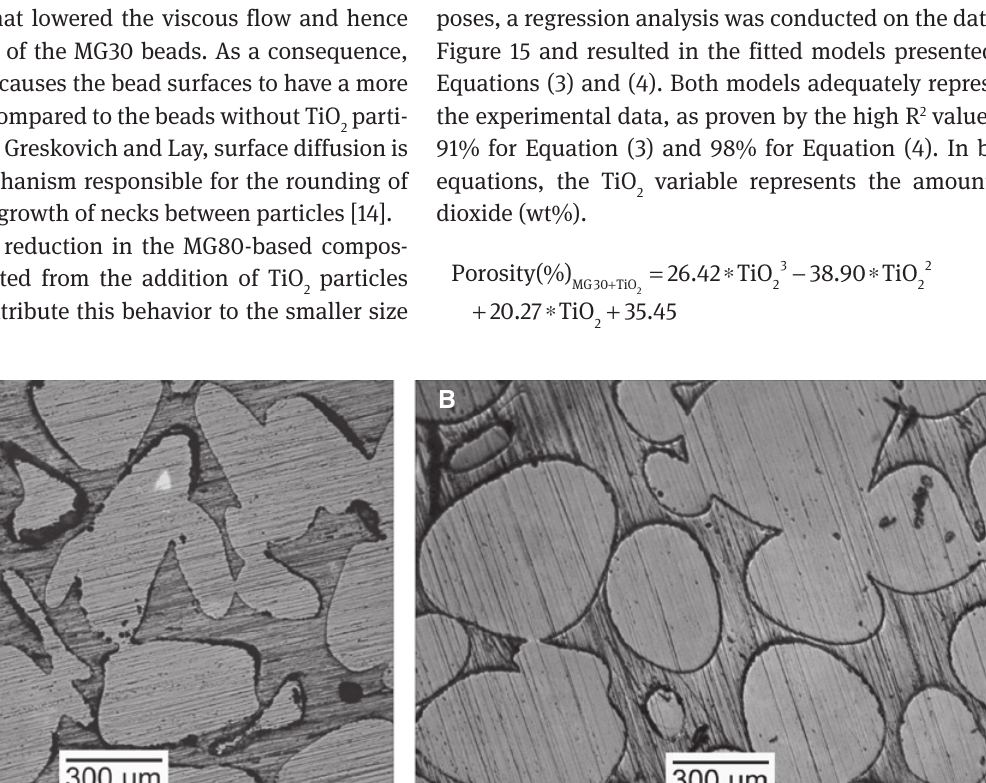
Figure 13: Optical micrographs of MG30 recycled glass with (A) 0 and (B) 0.7 wt% TiO